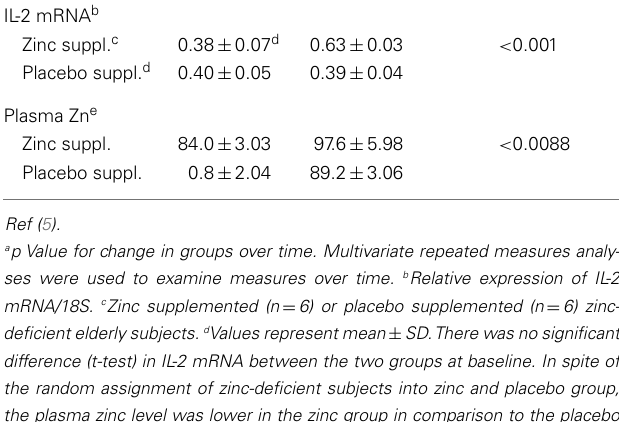
Table 2 | Effect of zinc and placebo supplementation on clinical variables .